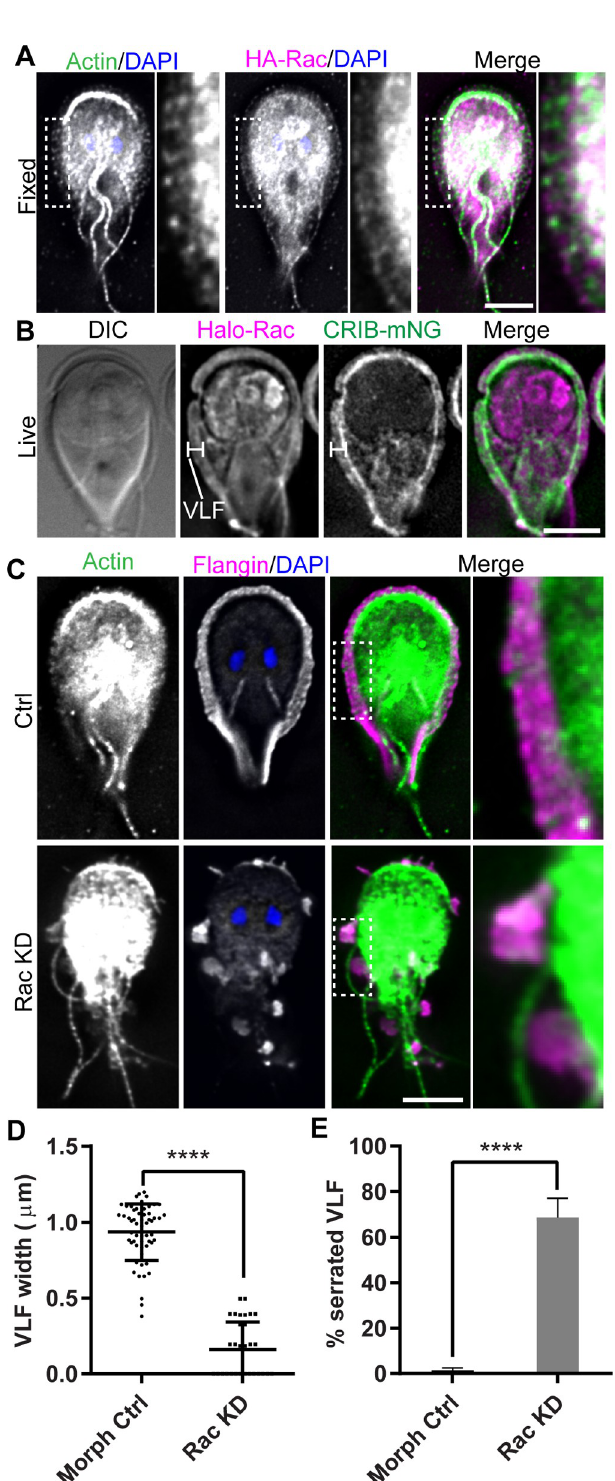
Fig 5. Gl Rac signaling is required for flange assembly. (A) Immunofluorescence localization of Gl Actin (green), HA-Rac (magenta), and DNA (blue). Gl Actin and Gl Rac localize to the flange. (B) Live cell imaging of Halo-Rac (magenta) and CRIB-mNG (green) indicate that Gl Rac is actively signaling in the flange. (C) Gl Rac KD resulted in a serrated flange phenotype not observed in control cells. Gl Actin and Flangin localize to the remaining sporadic flange protrusions. (D) Quantification of flange width measured at cell anterior from three independent experiments: control